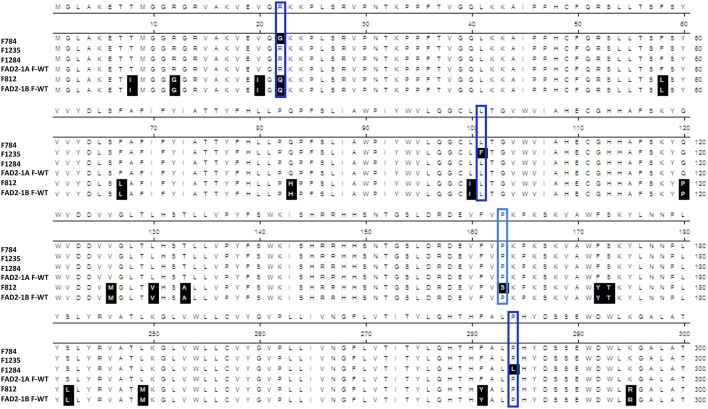
FAD2 mutations of the four screened oleic acid mutants. Protein sequence alignement of FAD2-1A, FAD2-1B, wild type Forrest, and the four screened missense mutants showing the identified substitutions: F784 (FAD2-1AR22G), F1235 (FAD2-1AF101L), F1284 (FAD2-1AP284L), and F813 (FAD2-1BP163S). Only sequences containing amino acid changes are represented, and thus, sequences from 181 to 240 are not shown.